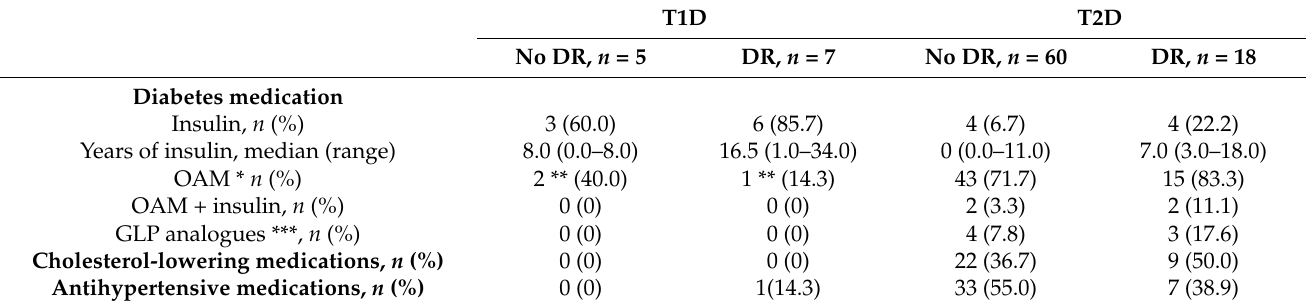
Table 3. Diabetes, cholesterol-lowering and antihypertensive medications used in the studied population. T1D